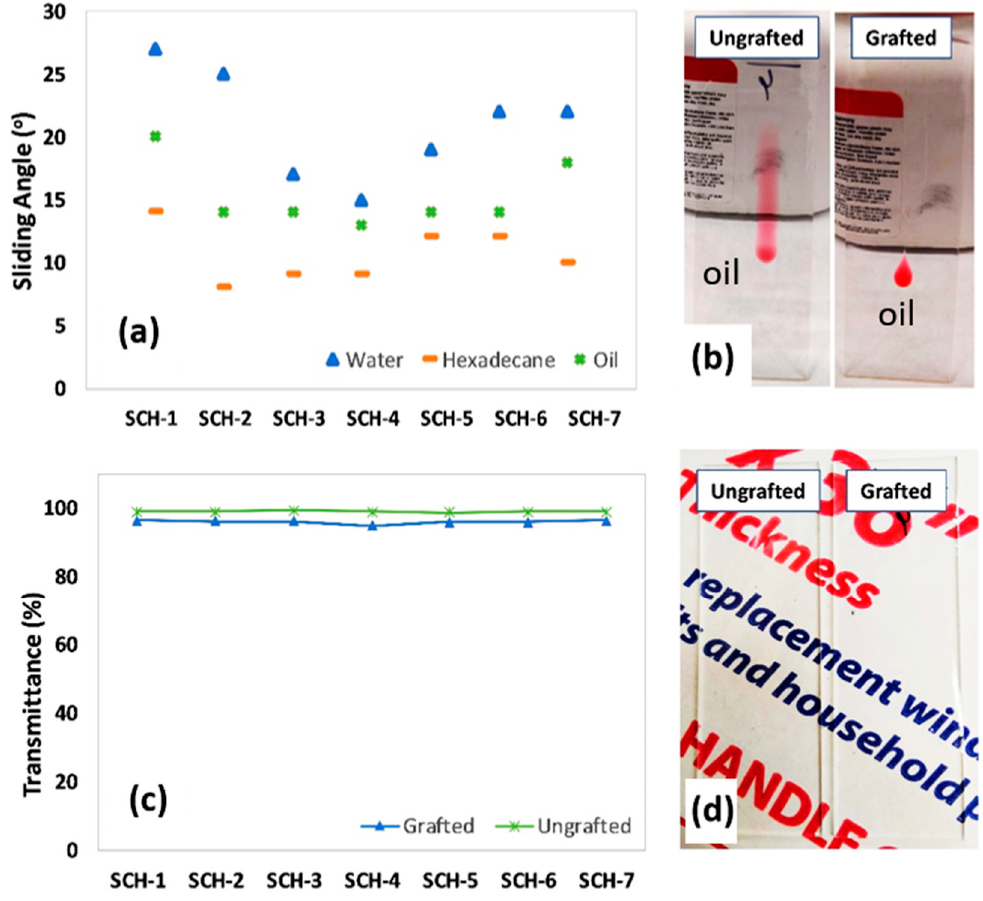
Figure 7. Sliding angles of water (80 µ L), vegetable oil (10 µ L), and hexadecane (10 µ L) droplets on various PDMS-grafted PU surfaces ( a ). Oil-sliding behavior on the surfaces of PU (neat) and PDMS-PU surfaces (SCH-4) ( b ). Optical transmittance measurements revealed that the prepared coatings are quite transparent and that the grafting of PDMS did not affect the optical clarity ( c ). Photographs of PU- and PDMS-PU (SCH-4) coated glass slides ( d ).